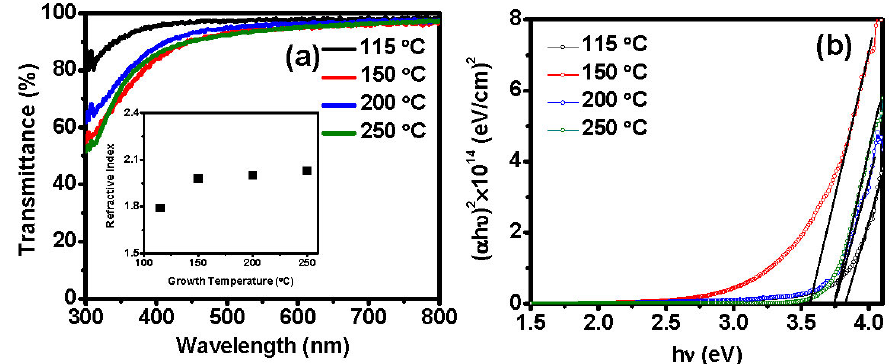
Figure 6. ( a ) The transmittance spectra with (inset) the variation of refractive index for the films deposited at 115 °C, 150 °C, 200 °C, and 250 °C with 1000 ALD cycles, ( b ) Tauc plots of ( α h ν ) 2 vs. h ν for extracting the optical bandgap energy and (inset) the extracted bandgap energy of In 2 O 3 films grown at 115 °C, 150 °C, 200 °C, and 250 °C.